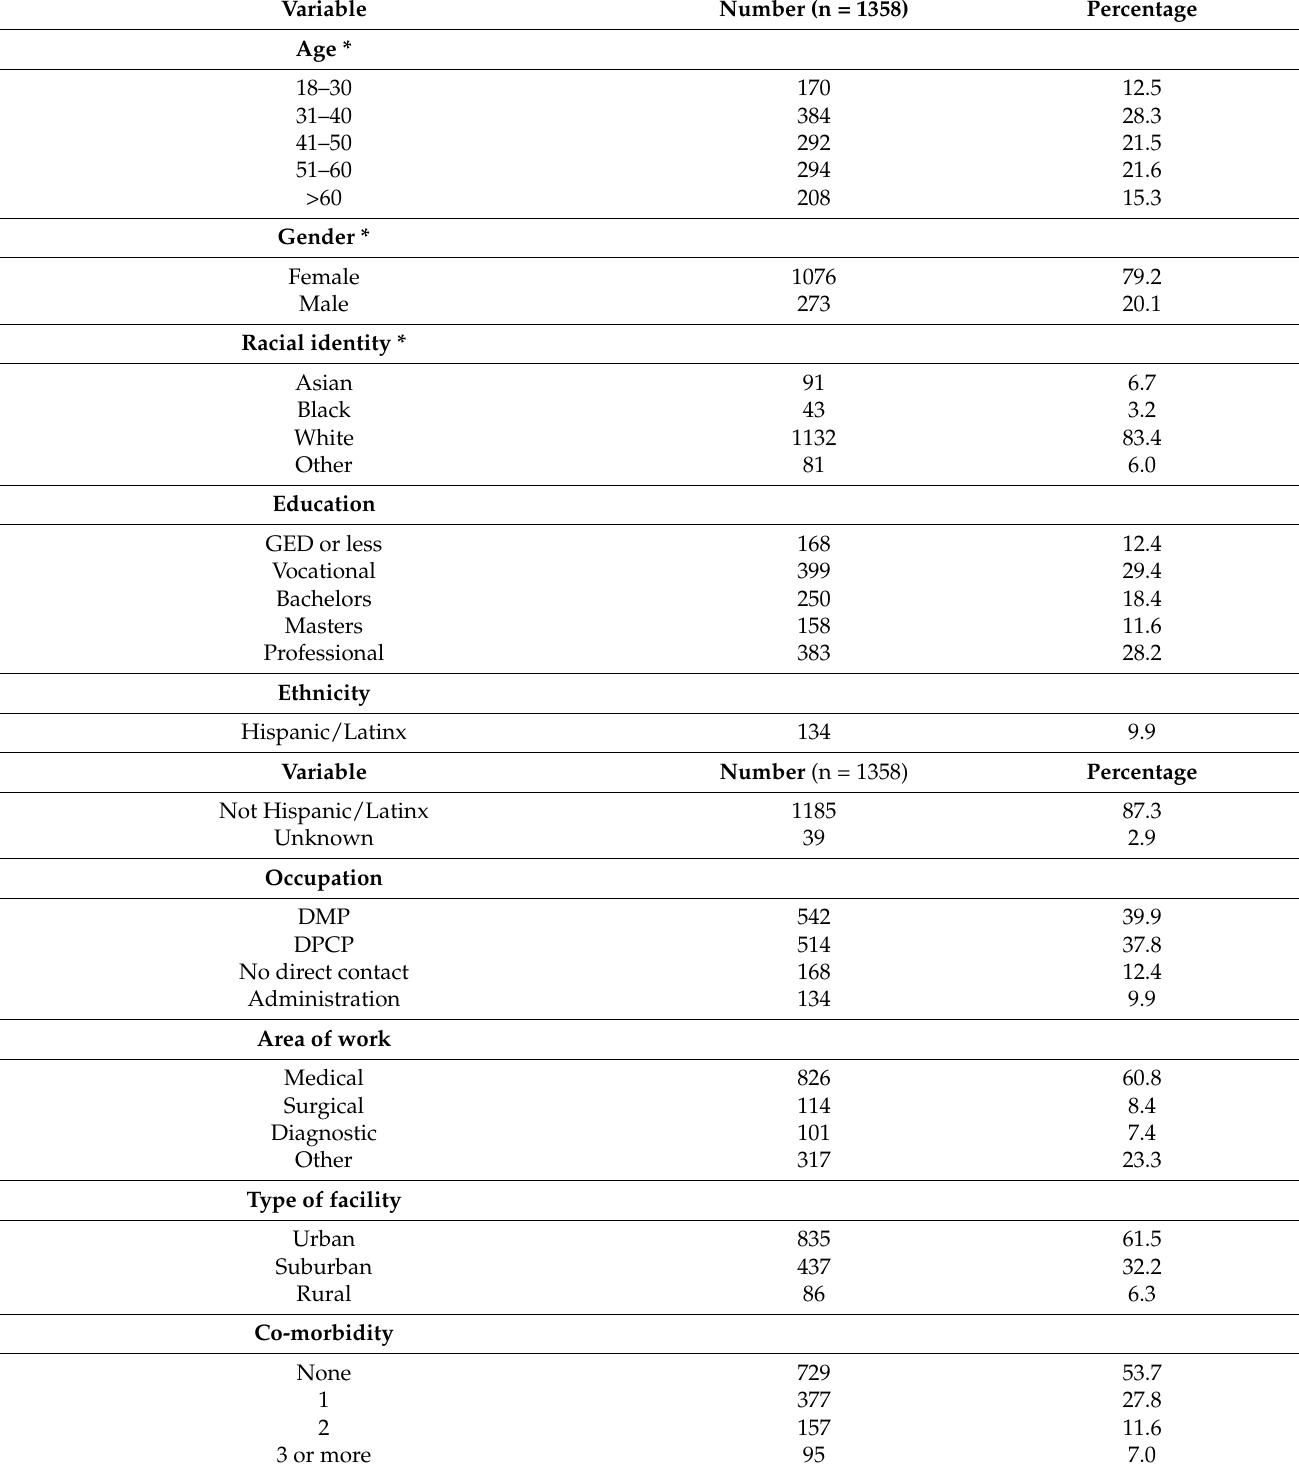
Table 1. Demographics of study